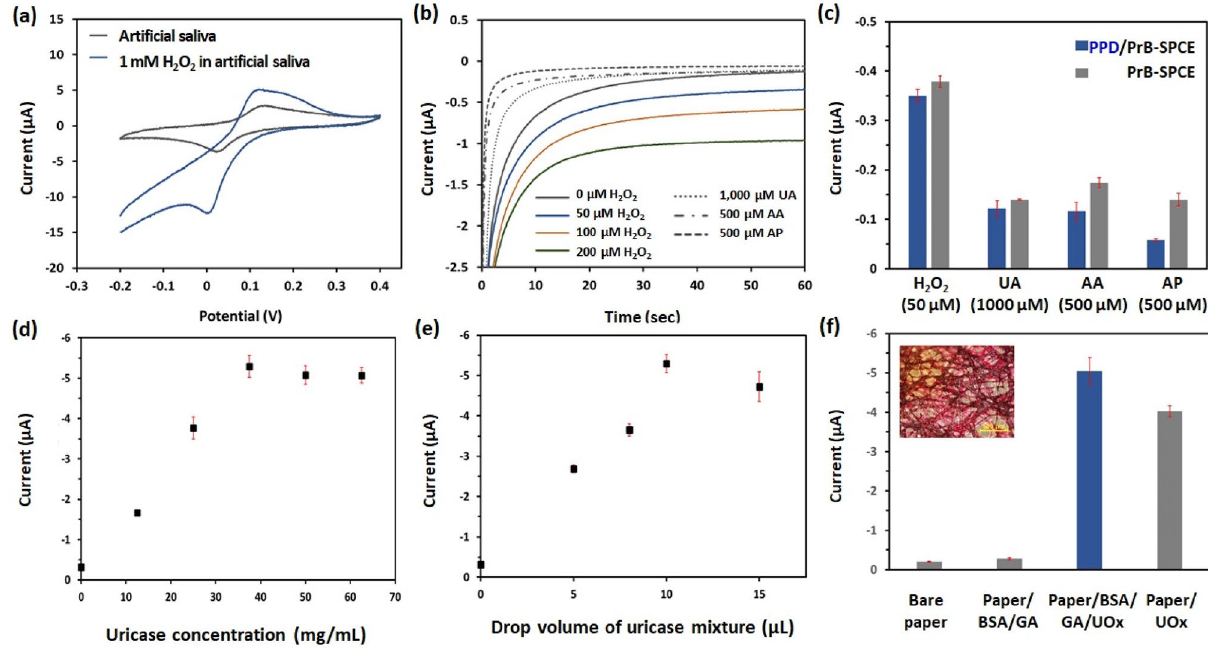
Figure 2. ( a ) Cyclic voltammograms of PPD/PrB-SPCE in an artificial saliva solution with and without 1.0 mM H 2 O 2 at a potential ranging from − 0.2 to 0.4 V (vs. Ag pseudo-reference electrode) and a scan rate of 50 mV/sec. ( b ) Current response to 0, 50, 100, and 200 μM H 2 O 2 of PPD/PrB-SPCE compared with response to common electroactive interferences including 1000 μM UA, 500 μM AA, and 500 μM AP. ( c ) Comparison of the electrochemical response of PPD/PrB-SPCE and PrB-SPCE to 50 μM H 2 O 2 and 1000 μM UA, and 500 μM AA, and 500 μM AP, respectively, at − 0.1 V (vs. Ag pseudo-reference electrode). Effect of ( d ) UOx concentration, ( e ) drop volume of UOx mixture, and ( f ) UOx immobilization method on the analysis of 1000 μM UA. Error bars represent standard deviation of the mean (n =